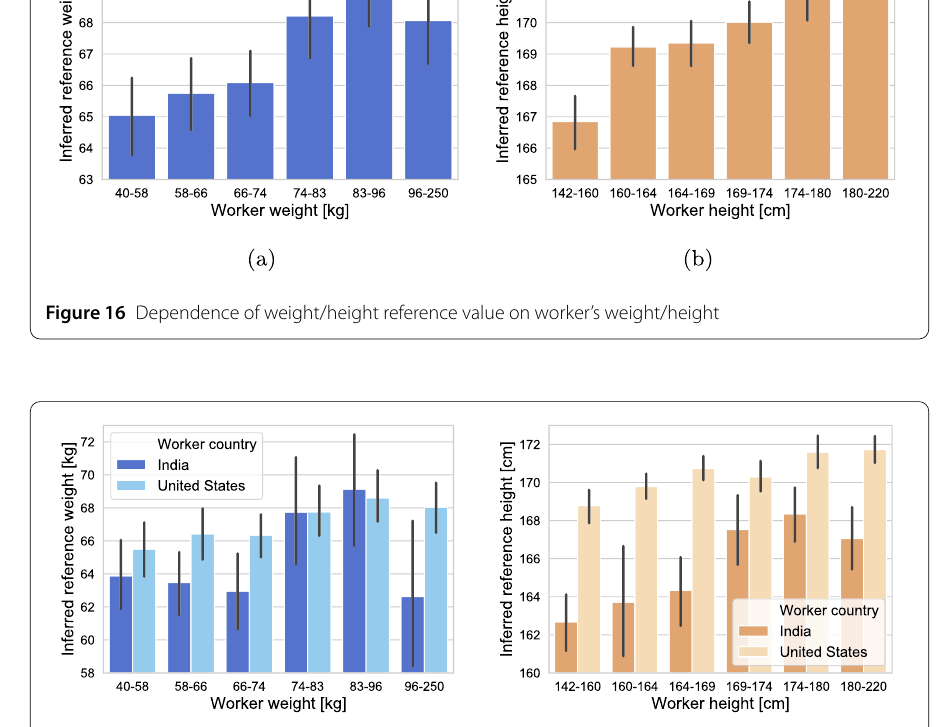
the worker’s own weight and height. Note how the dependence for weight breaks